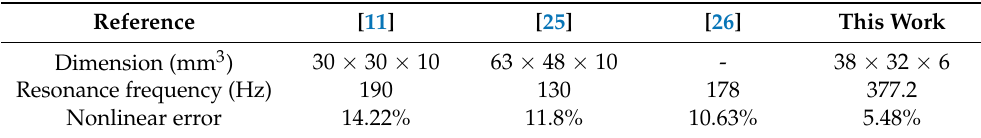
Table 2. Performance comparison of different